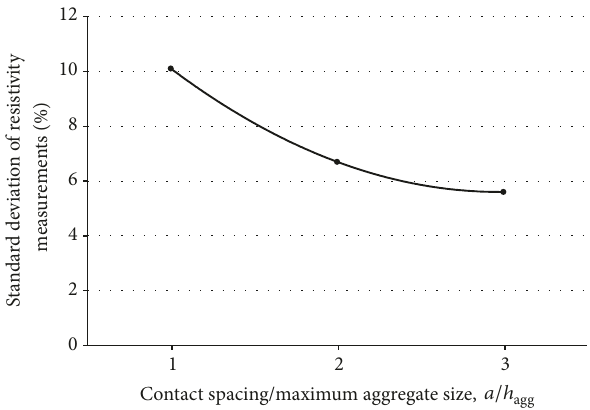
Figure 8: Effect of contact spacing on resistivity measurement